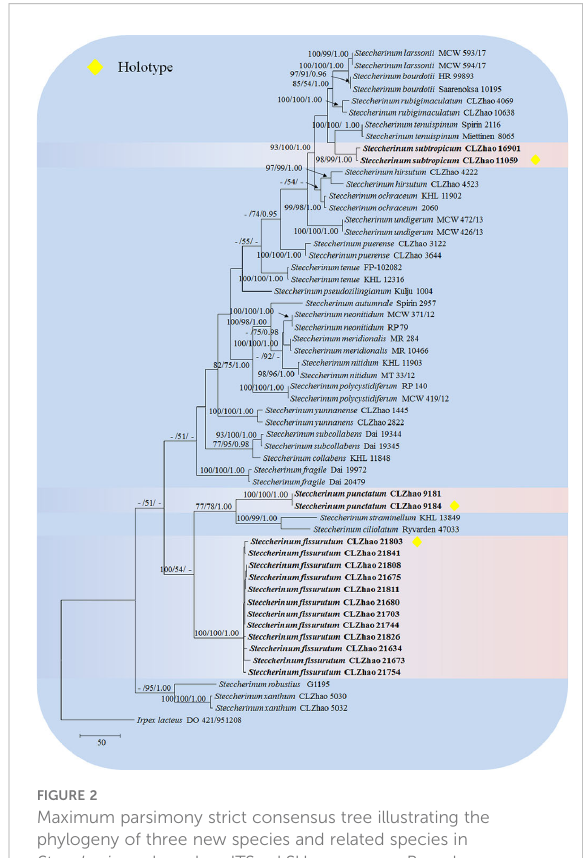
FIGURE 2 Maximum parsimony strict consensus tree illustrating the phylogeny of three new species and related species in Steccherinum based on ITS+nLSU sequences. Branches are labeled with maximum likelihood bootstrap values higher than 70%, parsimony bootstrap values higher than 50% and Bayesian posterior probabilities more than 0.95